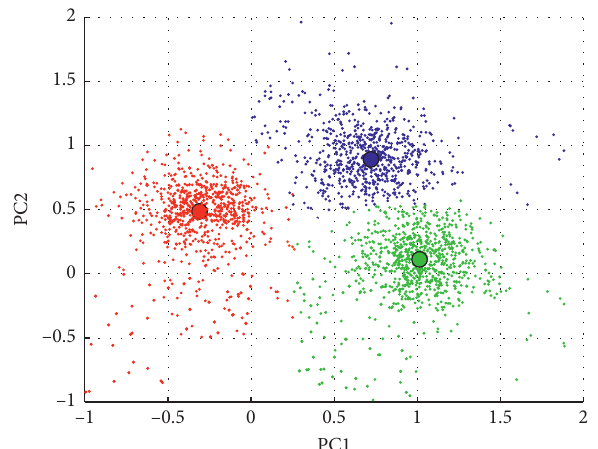
Figure 5: Extraction result of different anomalous conditions.